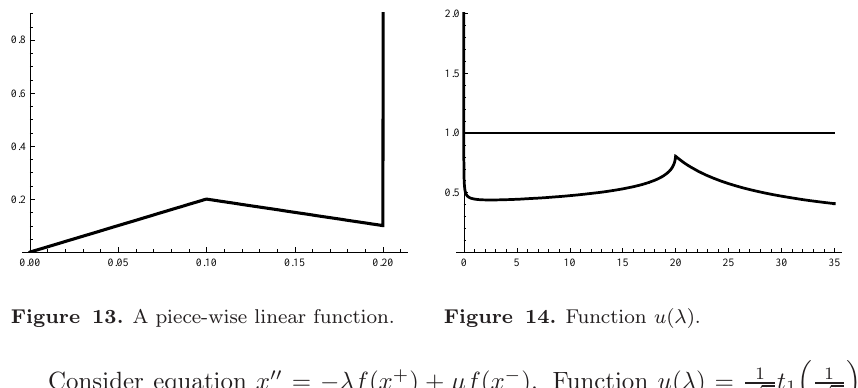
Figure 13. A piece-wise linear function. Figure 14. Function u ( λ )